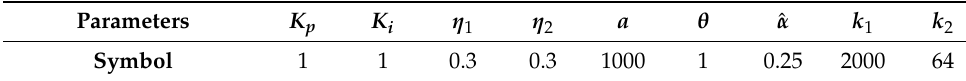
Table 4. The key parameters of the proposed MFSTNLSMC strategy.